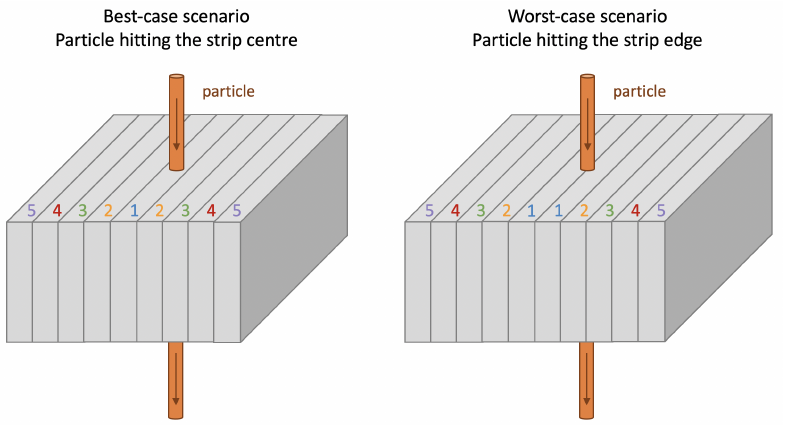
Figure 8. Best-case and worst-case scenarios considered in the TCAD transient simulations. The microstrips are represented as adjacent grey blocks, and the particle traversing the domain is shown as an orange cylinder. The nomenclature used to identify the microstrips (from 1 to 5) is illustrated.